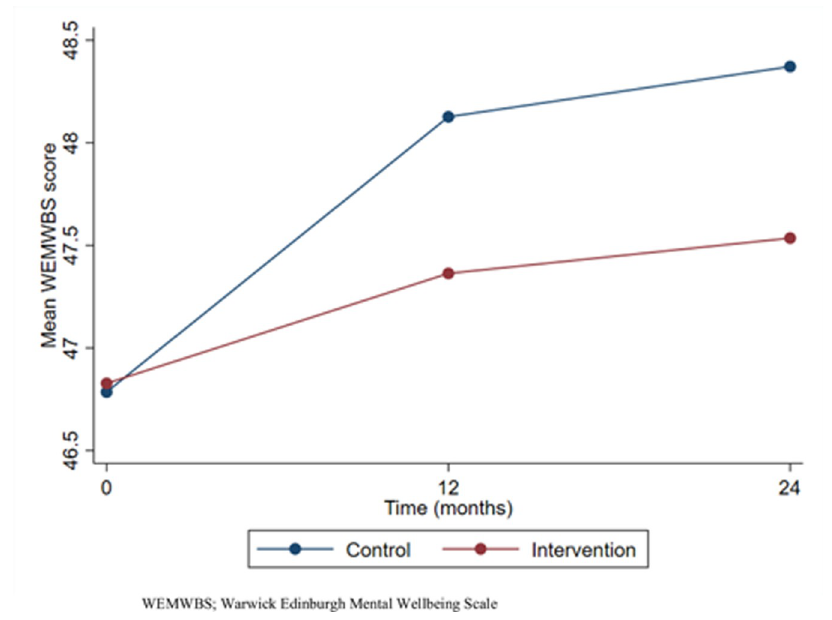
Fig 4. Teacher well-being over time. WEMWBS, Warwick-Edinburgh Mental Well-being Scale.